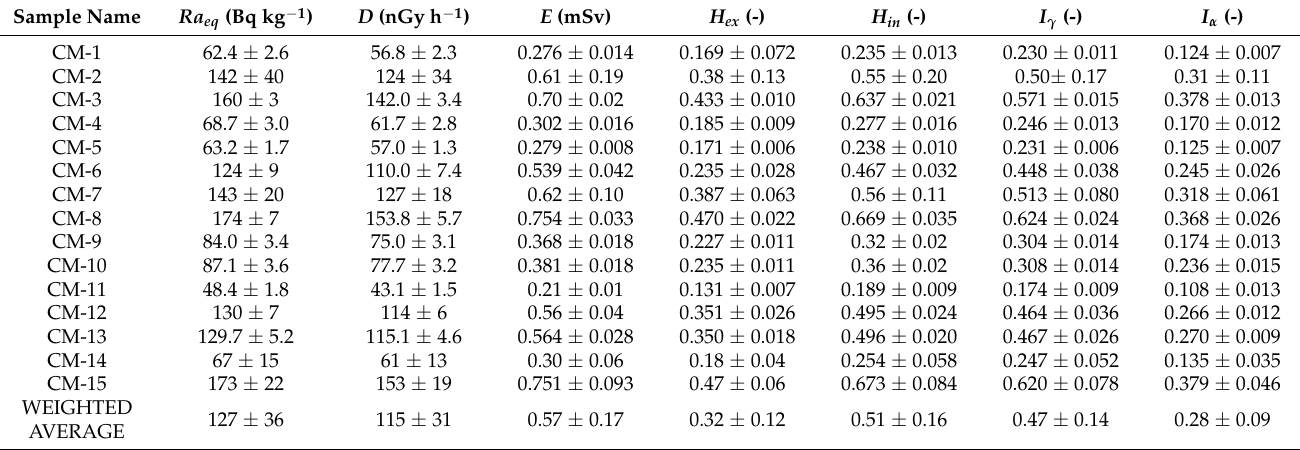
Table 6. Values of radiological parameters of the tested cements: radium equivalent activity index ( Ra eq ), gamma radiation dose level set out inside a premise ( D ), annual effective dose ( E ), external hazard index ( H ex ), internal hazard index ( H in ), gamma radiation activity index ( I ă ), the alpha radiation index ( I á ), all including the calculated